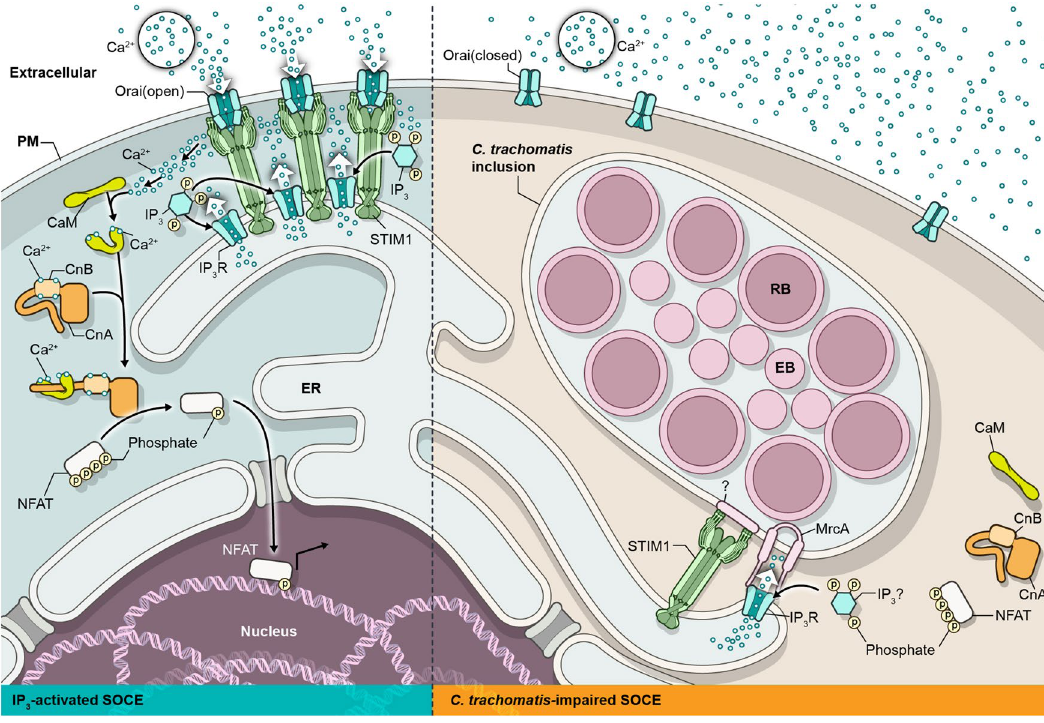
Figure 5. Working model for C. trachomatis impaired SOCE. Typical NFAT mobilization induced by SOCE in uninfected cells (left side) compared to a working model for C. trachomatis impaired SOCE (right side) and subsequent inhibition of calcineurin/NFAT signaling of the host cell. See text for details. The figure was created by the NAID Visual and Medical Arts Unit of the Research Technologies Branch as part of their official duties using Adobe Illustrator v26.0 https:// www. adobe. com/ produ cts/ illus trator. different pools of mCherry-STIM1 localized to the inclusion or the ER, Orai1-GFP did not associate with the inclusion membrane. When these cells were induced with TG to undergo SOCE, the inclusion membrane-asso- ciated mCherry-STIM1 remained at the inclusion, but the pool of ER-distributed mCherry-STIM1 demonstrated punctate staining indicative of ER-PM junctions necessary for the formation of CRAC channels. This suggested that an unknown chlamydial factor retains STIM1 at the inclusion membrane when CRAC channel formation is induced and likely limits the amount of available STIM1 for formation of these channels. Some caution must be exercised in interpretation of these results since overexpression of STIM1 or Orai1 can dramatically increase the number of CRAC channels 40 . The stoichiometry of STIM1 to the C. trachomatis sequestering agent will thus be important when assessing the influence of C. trachomatis on SOCE since STIM1 binding to the inclusion mem- brane presumably lowers the available STIM1 for binding Orai1 and could lower the endogenous STIM1:Orai1 molecular ratio. Re-analysis of the data from Dzakah 41 revealed that none of the isoforms of STIM1 or Orai1 were significantly up- or down-regulated at 20 h post chlamydia infection. As to whether or not STIM1 expressed at endogenous levels are able to form puncta in infected cells remains unclear. The primary sites of C. trachomatis infection for genital infections in women and ocular infections are the endocervical epithelium and conjunctival epithelium, respectively 4 . As the first targets of infection, mucosal epithelial cells act as first responders to pathogen challenge by the secretion of cytokines and chemokines, and thus play a key role in the innate immune response 42 . In an immortalized primary human endocervix-derived epithelial cell line, a productive C. trachomatis infection mitigated a pro-inflammatory cytokine and chemokine response. Although the mechanism was not defined, it was proposed that the circumvention of a robust cytokine and chemokine response represented a potential evasion strategy promoting the establishment of a favorable intracellular niche within the endocervix epithelium 43 . SOCE impacts cytokine and chemokine signaling events 31 . The influence of C. trachomatis -mediated suppression of SOCE warrants further investigation. The impairment to calcineurin activation and NFAT1 nuclear translocation demonstrates a specific signaling pathway that is affected by chlamydial suppression of SOCE. Although the major functions of NFAT are often considered in innate immune cells such as lymphocytes, macrophages, dendritic cells, or neutrophils, NFAT plays multiple additional roles in development and cellular differentiation 19 . NFAT is also expressed in multiple cell types 19 , including epithelial cells 44–46 and endothelial cells 47 , however, direct information on how disruption of NFAT signaling might impact pathogen interaction with epithelial cells is limited. African swine fever virus inhib- its NFAT-regulated transcription of immunomodulatory proteins by synthesis of a protein, A238L, that directly binds to and inhibits the calcineurin phosphatase activity required for NFAT activation 48 . Reactivation of latent Epstein-Barr virus to a lytic state via a Ca 2+ /calcineurin dependent activation of NFAT by a complex mechanism has been proposed to represent a negative feedback loop involving a viral protein, Zta, that directly binds to and